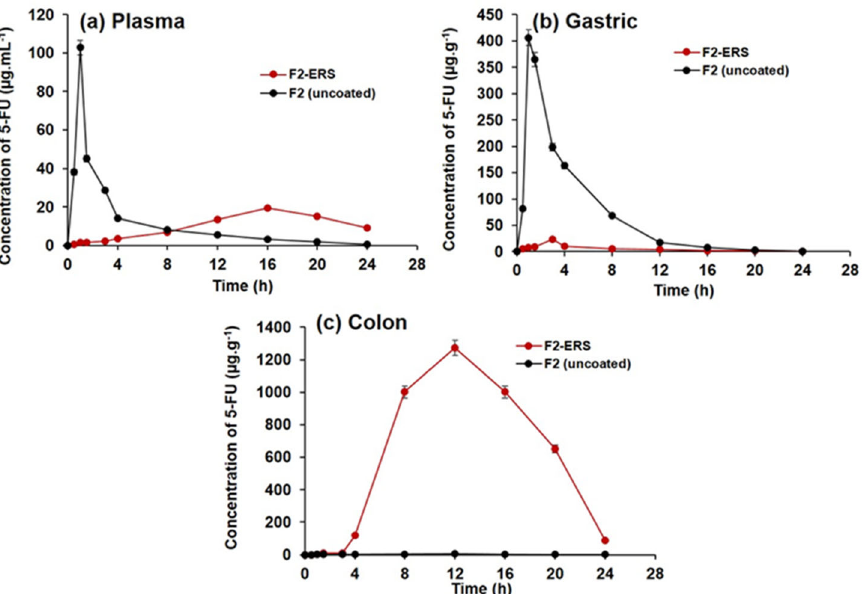
Figure 8. Concentrations versus time profiles of 5 ‐ FU in plasma ( a ); gastric tissue homogenates ( b ); and colonic tissue homogenates ( c ), after oral administration of 5 ‐ FU ‐ loaded SEMC (F2 uncoated) and colon ‐ directed Eudragit RS ‐ 100 ‐ coated F2. The data are represented as mean ± SD, ( n = 3).